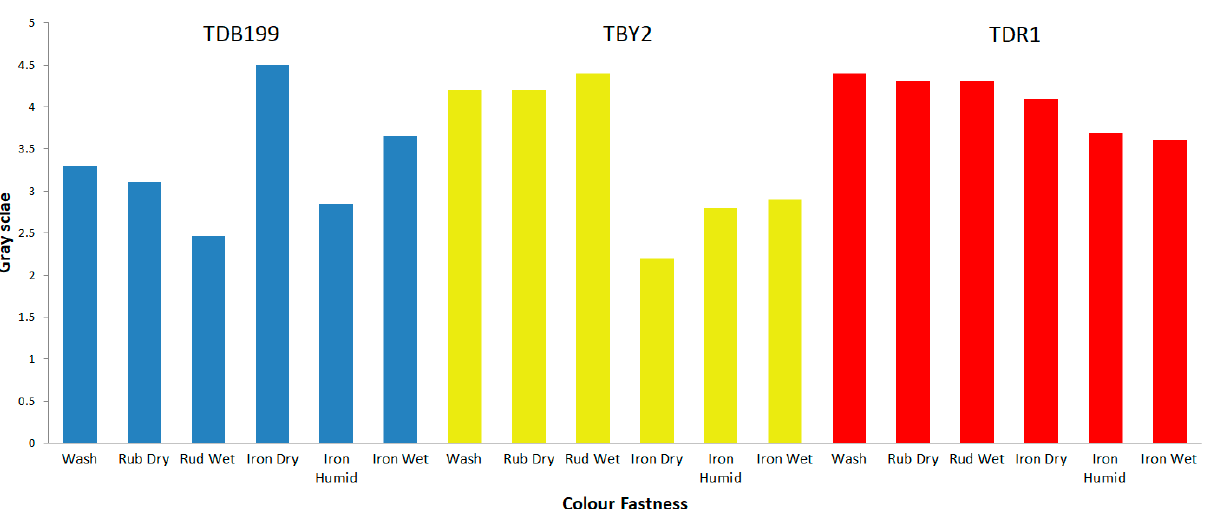
Figure 8. ( a ) SEM sample TDB199, ( b ) SEM sample TBY2, ( c ) SEM sample TDR1. 2.8. BET Surface Area and Porosity Measurements The BET surface areas, pore volumes and pore sizes are shown in Table 5. The results of hydrotalcite before and after calcination as well as after adsorption of the different dyes have been analysed and compared. The results show that surface area, pore volume and pore size increase after calcination. This is due to the fact that during calcination the clay structure opens up. Previous studies claim that these changes are due to outgassing for the catalysts produced by the decomposition of the hydrotalcite gases into their hydrated phases [63–65]. On the other hand, the samples that have adsorbed the dye have very similar values to those of the clay before calcination.